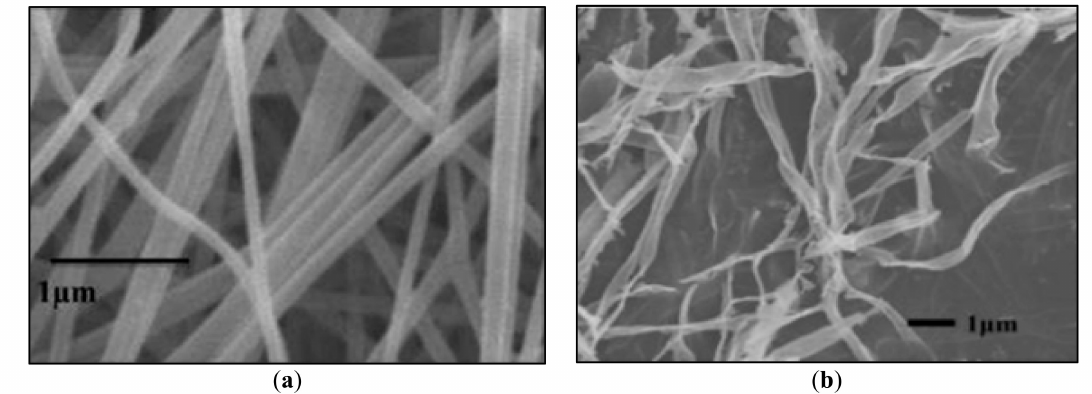
Figure 12. SEM images of ( a ) Fe-ZnO / PVA nanofibers [102]; ( b ) the wrinkled Ag / LaFeO 3 nanofibers